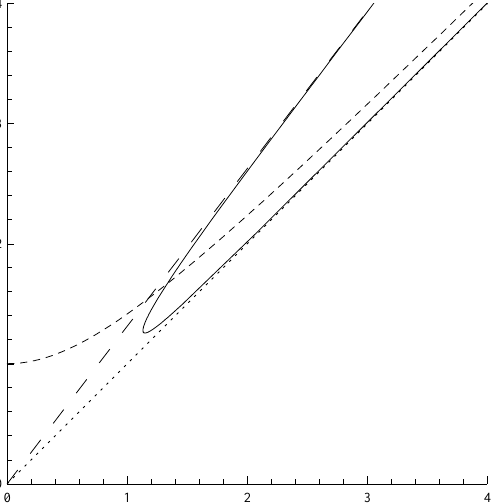
Figure 2. The hyperboloid x µ x µ = ∆ 2 , in units where ∆ 0 = 1 (dashed) and the light-cone (dotted). 0 The full line represents the world line (117), plotted in the half-plane spanned by ( 1, 0 ) and ( 0, n ) . When τ tends to 0, the curve escapes towards future-null infinity. The wide-dashed straight line is (cid:0) (cid:1) the asymptote (119), τ (cid:55)→ x τ cosh1, n sinh1